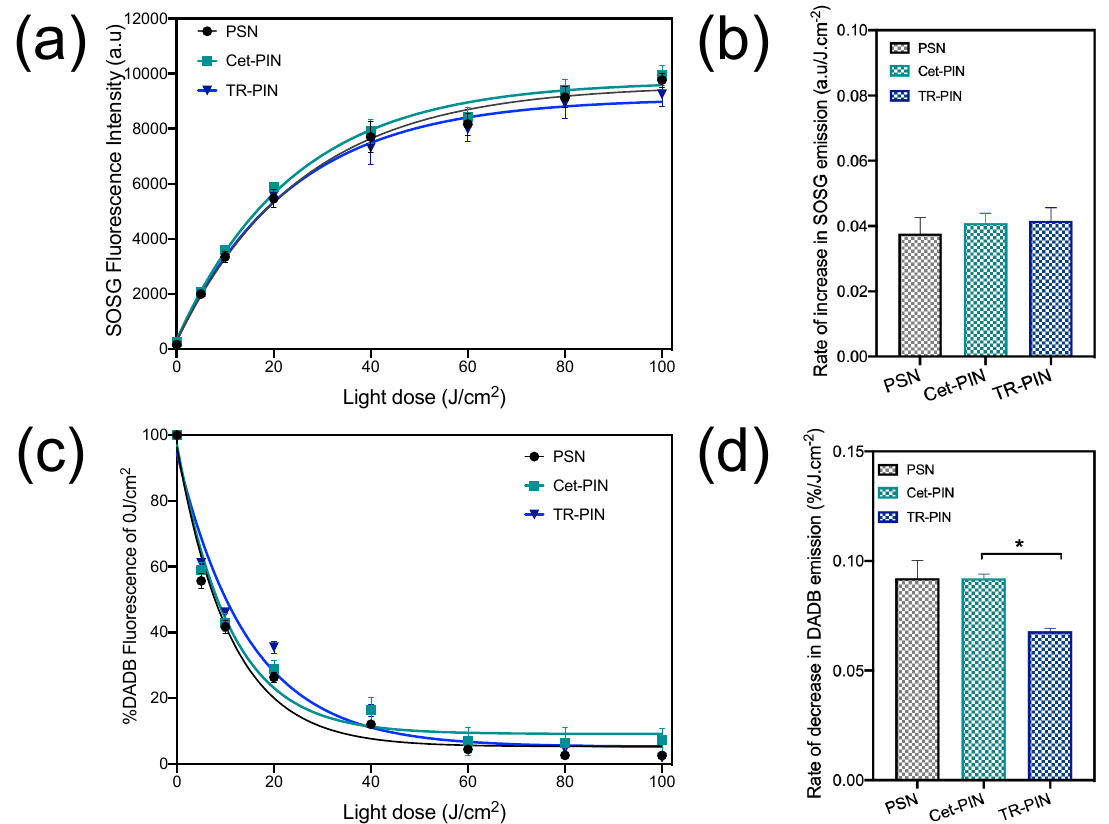
Figure 6. Singlet oxygen production monitored using SOSG and DADB. Singlet oxygen production as monitored using ( a – b ) SOSG (Exc = 460 nm, cut-o ff filter = 515 nm, Emi = 525 nm) and ( c – d ) DADB (Exc = 405 nm, cut-o ff filter = 475 nm, Emi = 505 nm) emission with increasing fluences of 690 nm light irradiation of untargeted-PSN, Cet-targeted PINs (Cet-PINs), and triple-receptor-targeted PINs (TR-PINs). The irradiance was maintained at 150 mW / cm 2 throughout. (mean ± S.E.M.; n = 4–8; one-way ANOVA with a Tukey post-test; * = p ≤